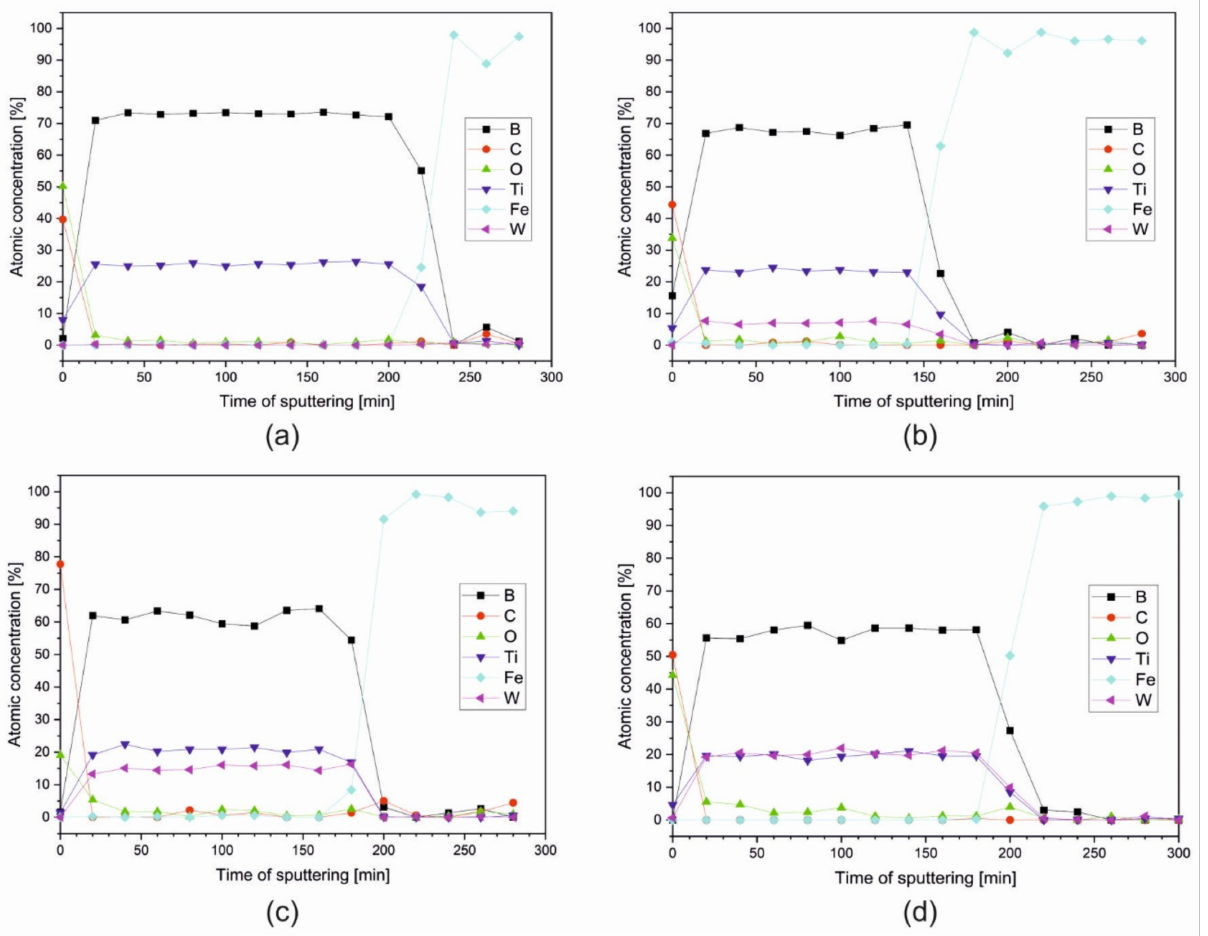
Figure 4. Atomic concentration depth profiles for coatings ( a ) TiB 2 ; ( b ) Ti 0.78 W 0.22 B 2 ; ( c ) Ti 0.58 W 0.42 B 2 ; and ( d ) Ti 0.5 W 0.5 B 2 obtained using XPS coupled with Ar ion